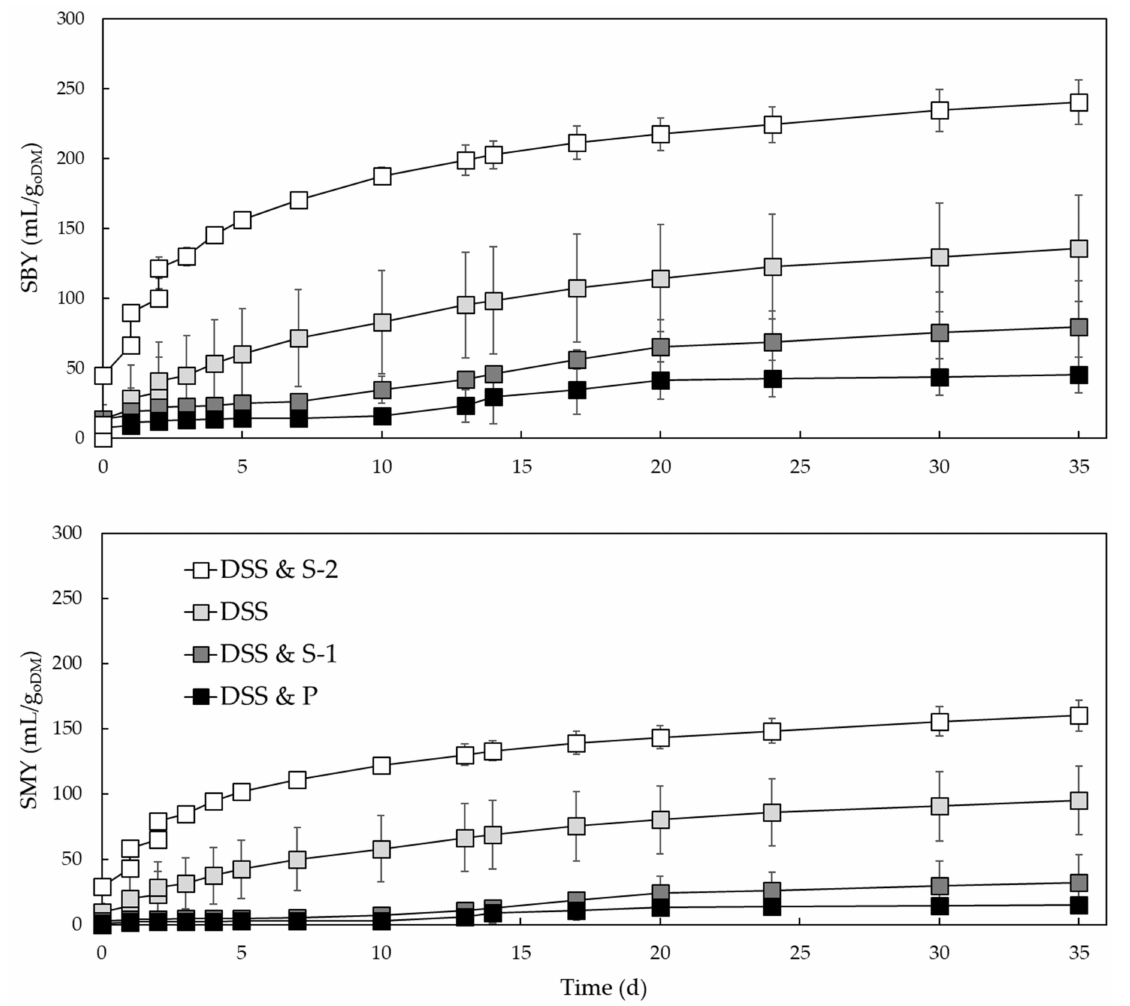
Figure 3. Specific biogas yield (SBY) and specific methane yield (SMY) based on organic dry mat- ter (oDM) for the mixtures of digested sewage sludge (DSS) together with spruce-based (S-1 and S-2) and poplar-based (P) press waters and for DSS (inoculum) alone. Mean values ± standard deviation (n = 3). Table 5. Masses of digested sewage sludge (DSS), spruce-based press water (S-1, S-2) and poplar- based press waters (P) based on dry matter (DM) and organic dry matter (oDM) in each digester